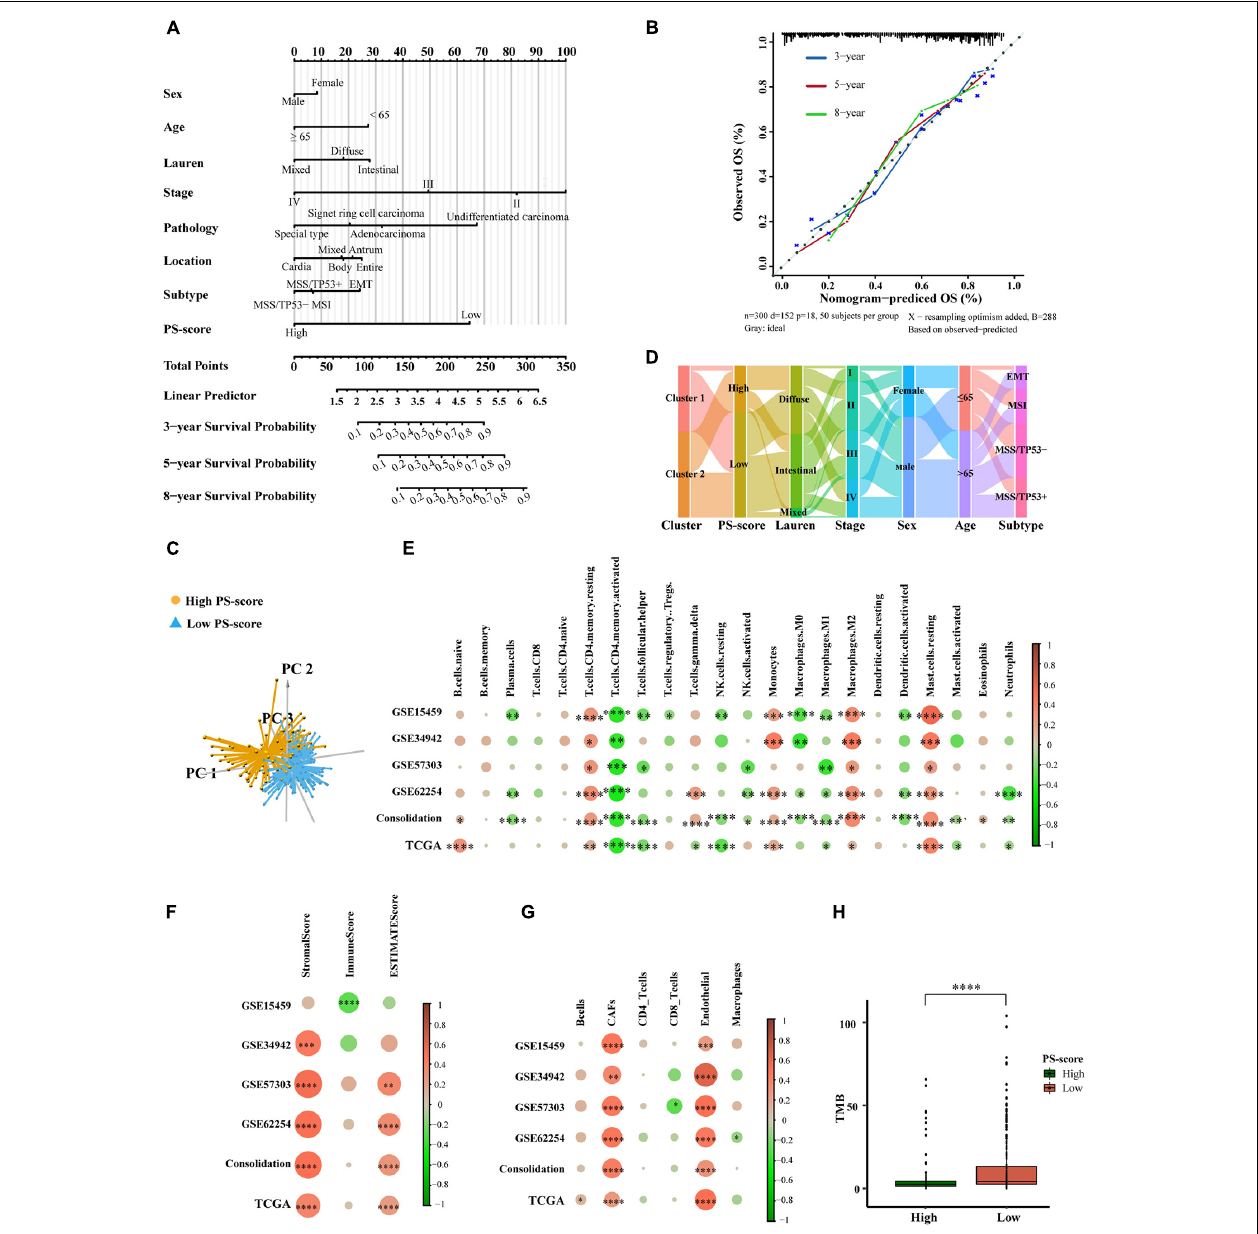
FIGURE 6 | The clinical application value of the PS-score scoring model and TME of different PS-score subgroups. (A) Nomogram for predicting 3, 5, and 8 years overall survival for gastric cancer patients in GSE62254 cohort. (B) Calibration curves of nomograms in terms of the agreement between predicted and observed 3, 5, and 8 years of outcomes in GSE62254 cohort. (C) Principal component analysis for the expression of the PS-score signature genes to distinguish low and high PS-score subgroups in GSE62254 cohort. (D) Alluvial diagram showing the changes of pyroptosis-related clusters, PS-score, Lauren type, TMN staging, sex, age, and ACRG subtypes in GSE62254 cohort. (E–G) The correlation between every type of TME infiltrating cells and PS-score analyzed, respectively, by CIBERSORTx, ESTIMATE score, and EPIC in cohorts (GSE15459, GSE34942, GSE57303, GSE62254, and TCGA-STAD; Consolidation was the cohort consolidating four GEO cohorts) (Spearman test, ∗ P < 0.05; ∗∗ P < 0.01; ∗∗∗ P < 0.001; ∗∗∗∗ P < 0.0001). Sizes of circles represented relevant correlation coefficients. (H) Tumor burden (TMB) of low PS-score subgroup ( n = 215) and high PS-score subgroup ( n = 153) in TCGA-STAD (Wilcox test, ∗∗∗∗ P <